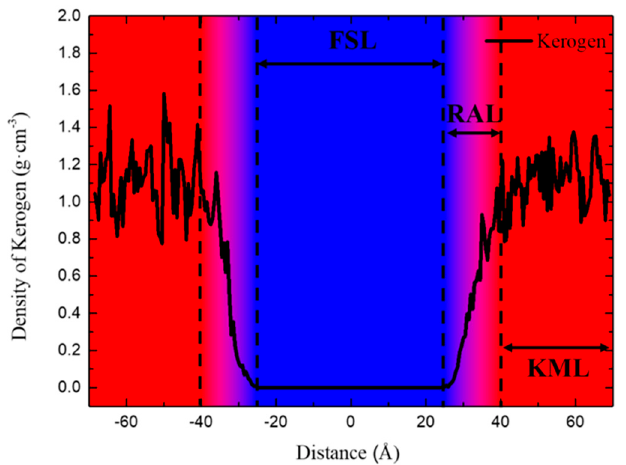
Figure 2. The density profile of kerogen. The dashed line segments represent the kerogen matrix layer (KML), rough adsorption layer (RAL), and free slit layer (FSL) systems.